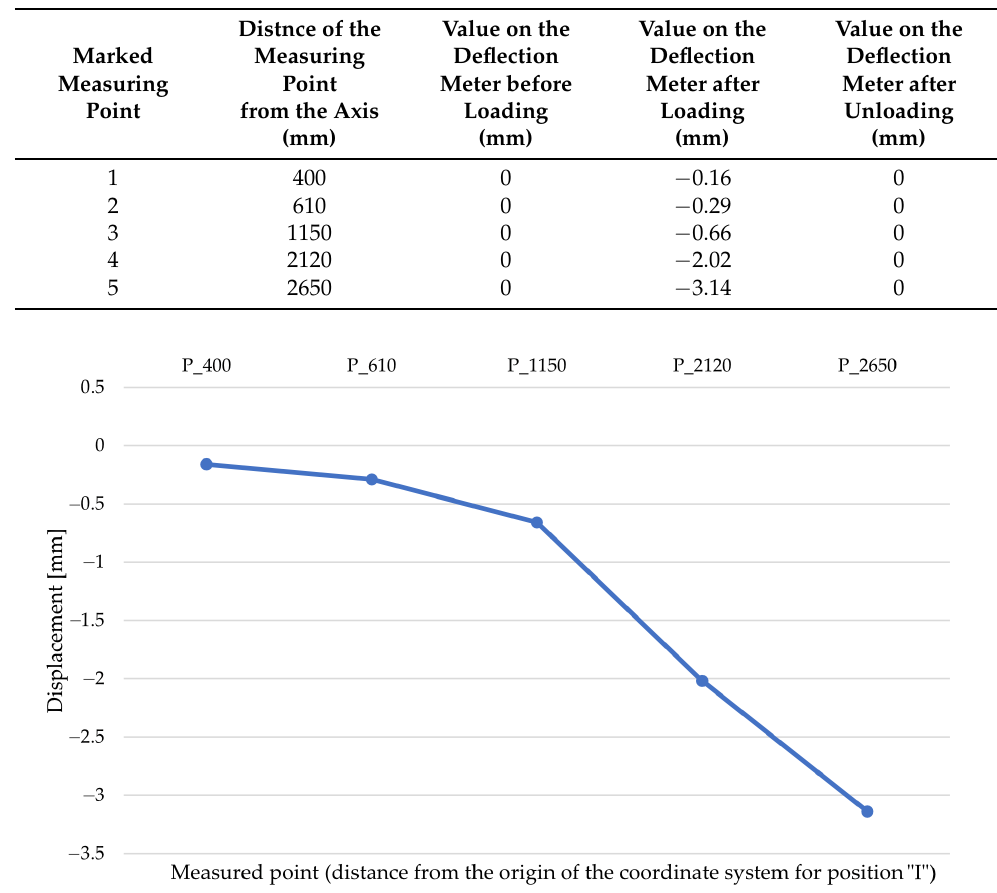
Table 3. Results of displacement measurements in the z -axis with a mechanical deflection meter.